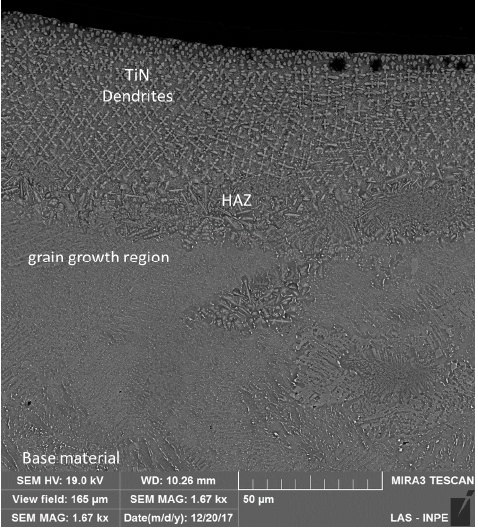
Figure 3. Longitudinal SEM of Widmanstätten microstructure after laser nitriding. Laser Power: 750 W.